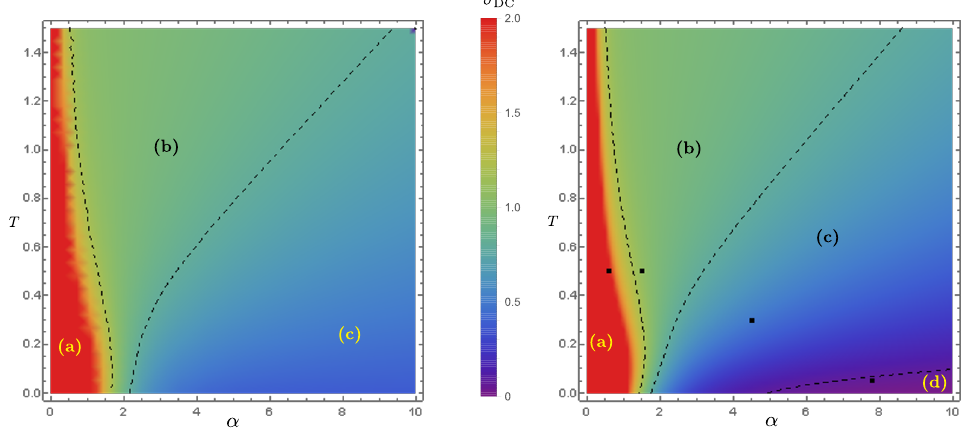
Figure 11 . Phases diagrams for the Exponential model with (cid:20) = 1 = 6 (left) and the Linear model with K = (cid:0) 1 = 6 (right), in the absence of an applied magnetic (cid:12)eld. Four regions are denoted by (a) good metal, (b) incoherent metal, (c) bad insulator and (d) good insulator, respectively. Following [27], the phase boundaries are denoted by the dashed lines corresponding to (cid:27) DC = 0 : 1 ; 0 : 8 ; 1 : 2. There is no region (d) for good insulator in the left plot. Each dark point in the right plot corresponds to the optical conductivity of (cid:12)gure 10. We have worked in the canonical ensemble with the charge density (cid:26) =